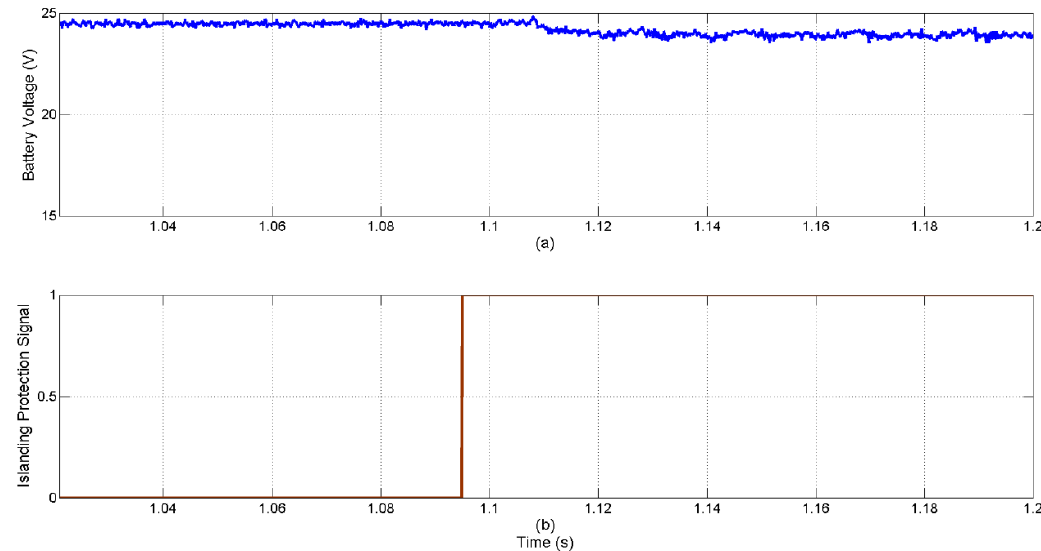
Figure 14. The waveform of the terminal voltage of the power unit when the power grid fails. ( a ) Terminal voltage of the power unit [V] ( b ) Terminal voltage of the power unit [Vrms] ( c ) Islanding protection signal.